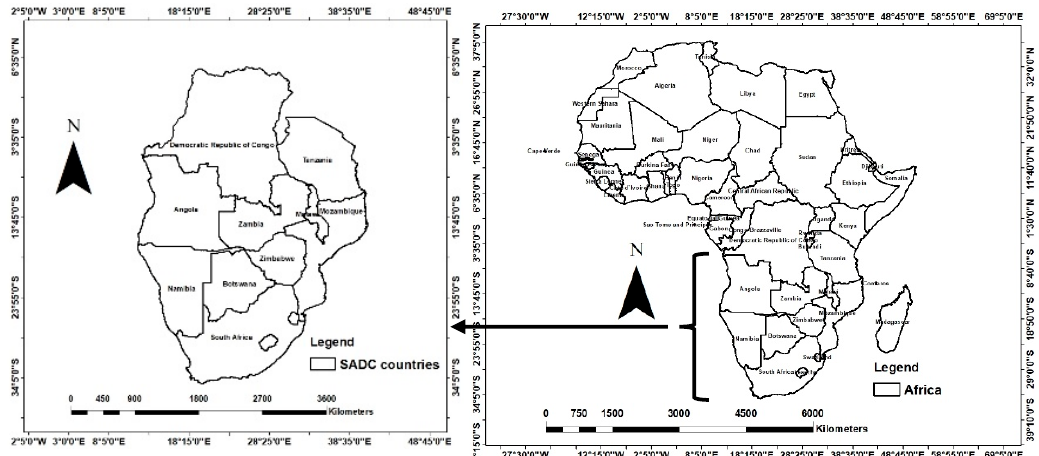
Figure 1. Map of the study area in Southern Africa.